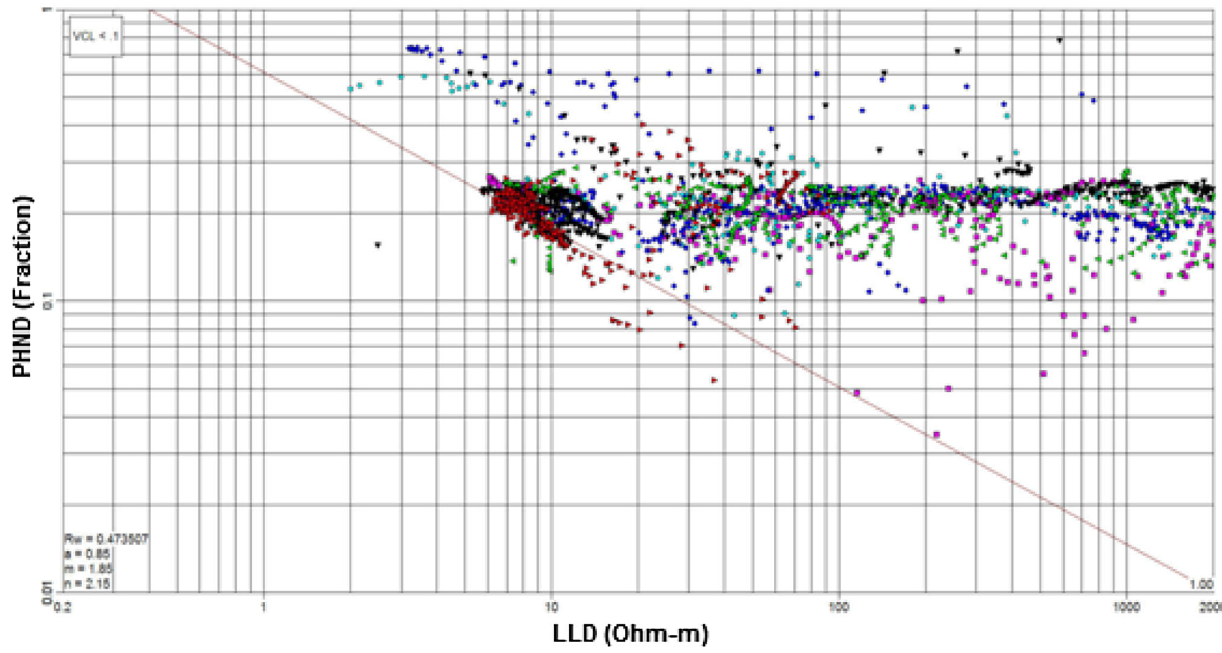
Fig. 14 Multi-well Pickett plot between PHID (density porosity) and LLD (deep resistivity) for determining R w